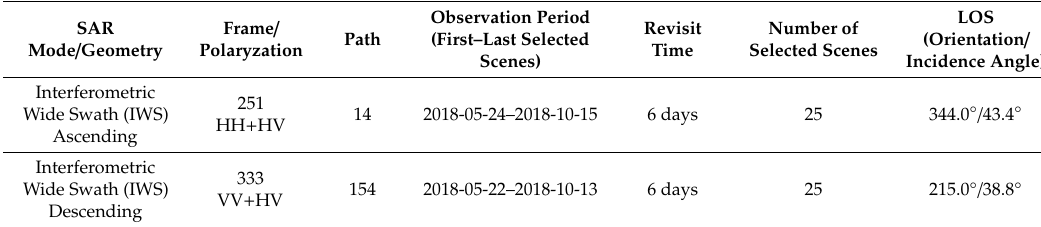
Table 3. S ynthetic Aperture Radar (SAR) scene data acquisition: basic